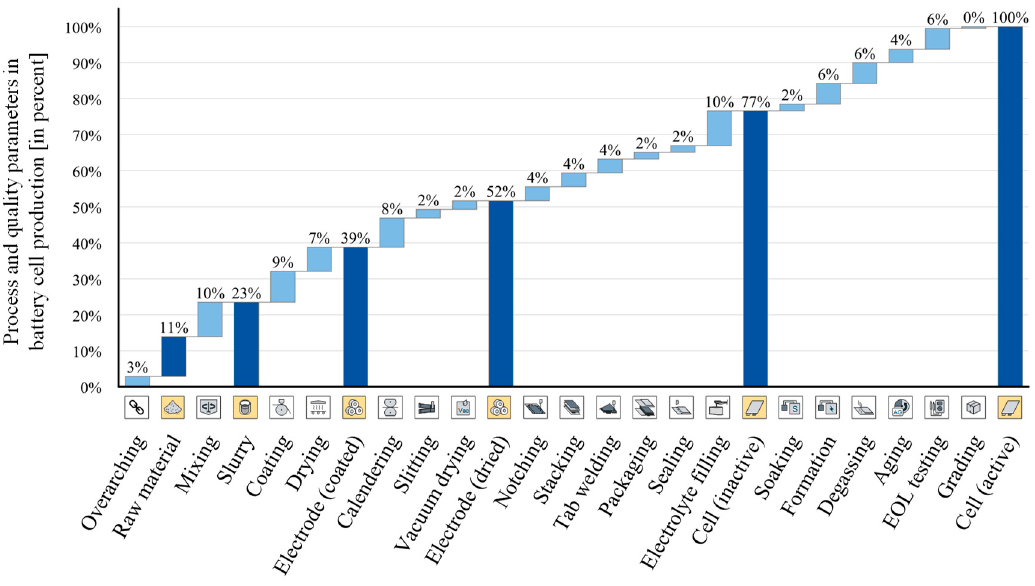
Figure 5. Relative distribution of process and quality parameters along the process chain.